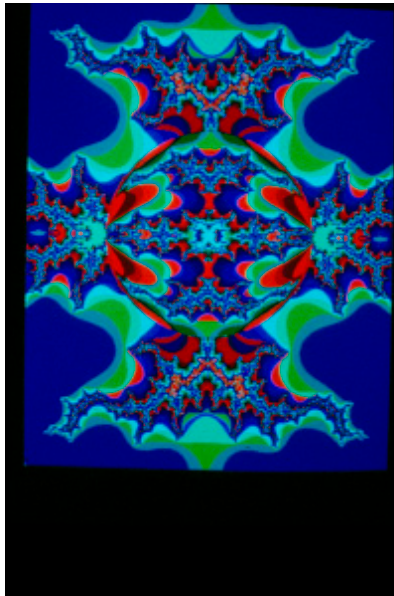
Figure 17. A screenshot, apparently derived from the Mandelbrot set, manipulated in a paintbox program, and captured on slide film by Ostoja. Published with permission. Image courtesy of the State Library of South Australia. SLSA: PRG919/22/866.